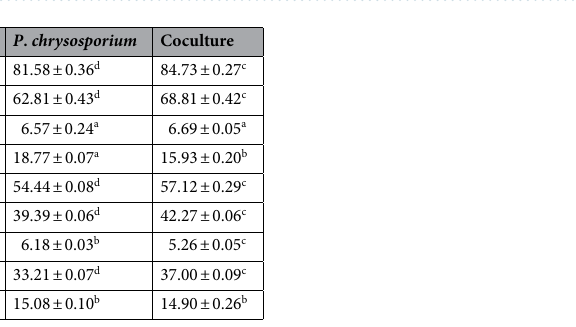
Figure 2. Rice straw after 30 days incubation: ( B ) untreated, ( B ) P. ostreatus, ( C ) P. chrysosporium, ( D ) Coculture.